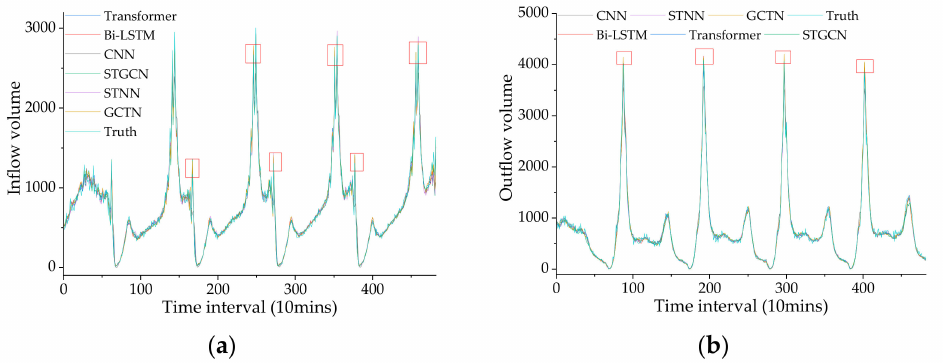
Figure 10. The prediction of passenger flow in the Xujiahui Station, ( a ) Inflow volume; ( b ) Outflow volume. The time interval is 10 min and the test period covers half a non-working day and four working